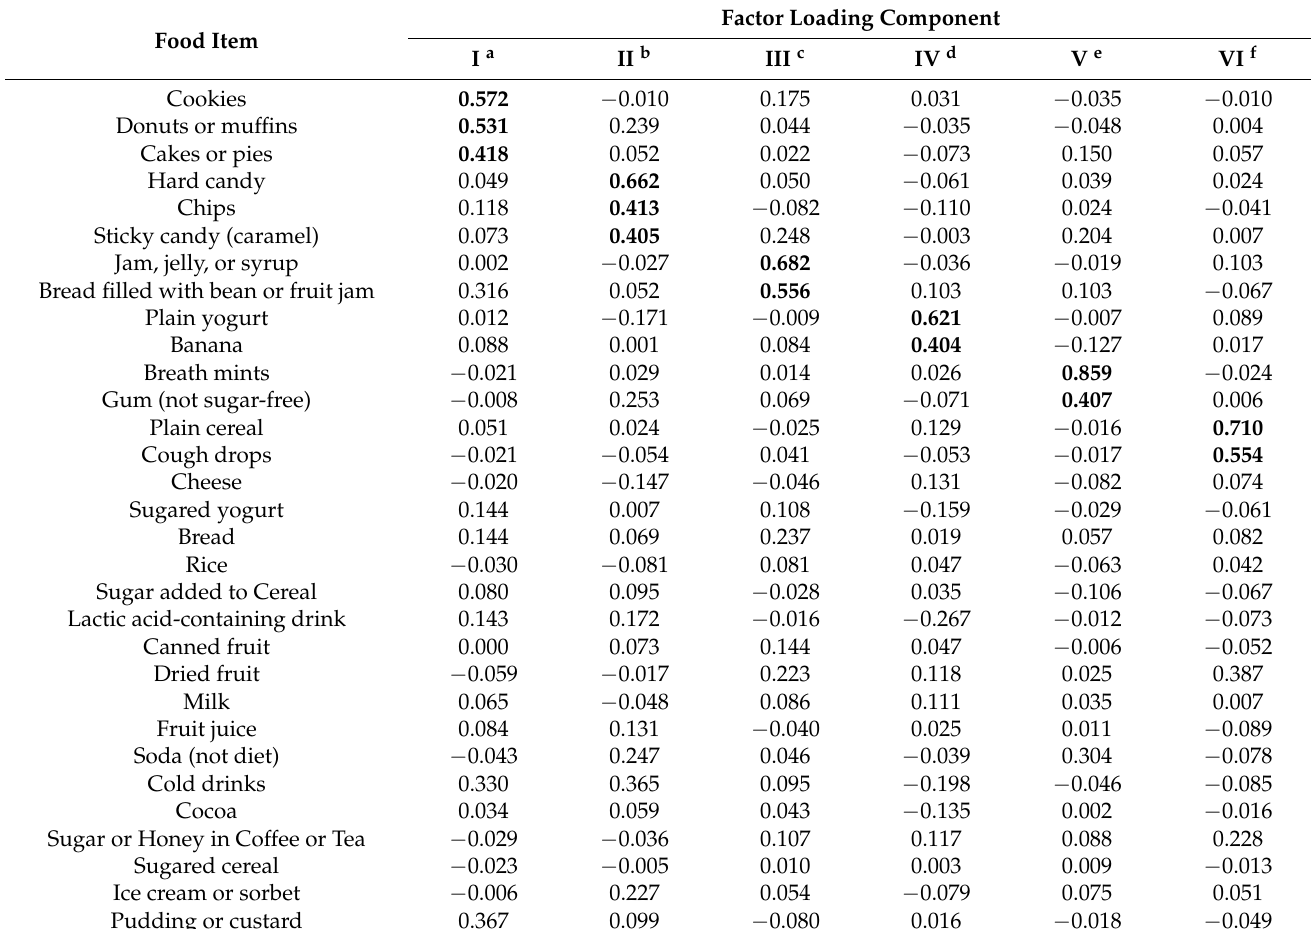
Table 3. Factor loadings, eigenvalues, variance explained from principal axis factoring with Varimax rotation, and Cronbach’s alpha for each factor in the Japanese version of the FFQ ( n =